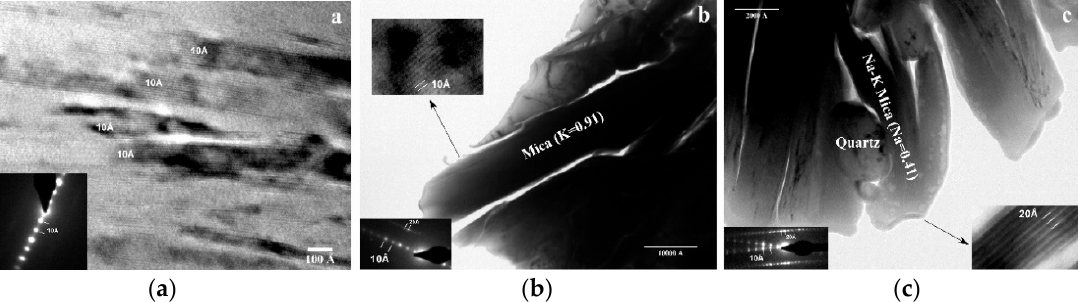
Figure 6. HRTEM and TEM images of micaceous phases of the Álava Trough sections: ( a ) Isolated, subparallel packets with 5–15 10 Å layers; ( b ) TEM and HRTEM images of a grain of detrital mica corresponding to a sample from the bottom of section R1. HRTEM reveals the typical mottled texture and very regular 10 Å spacing. The SAED image is characteristic of a 2 M polytype; ( c ) TEM image of an Na-rich detrital mica. The HRTEM image in the lower right hand corner shows 20 Å spacings caused by dynamic effects. The SAED image is of a 2 M polytype with a small variation in the crystallographic orientation between domains, related to the grain’s curvature.